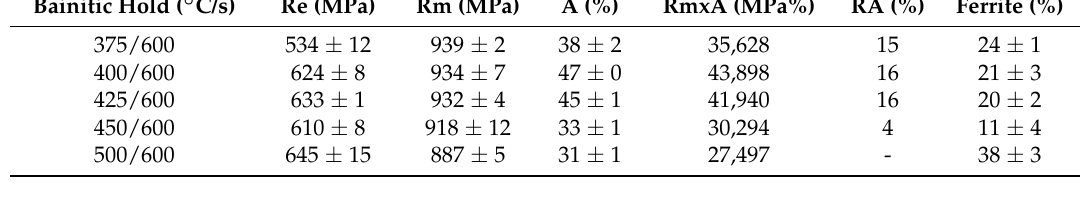
Table 4. Effect of bainitic hold on tensile strength, total elongation, formability factor and retained austenite volume fraction. Samples soaked at 850 ◦ C/100 s and subsequently cooled at 30 ◦ C/s.